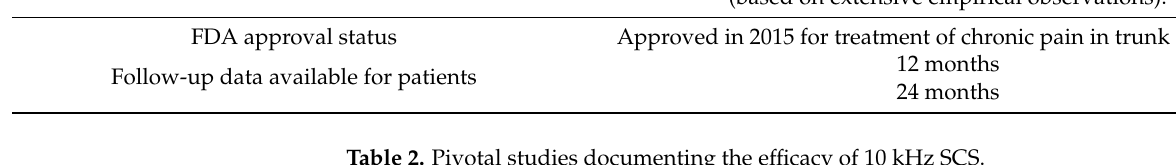
Table 2. Pivotal studies documenting the efficacy of 10 kHz